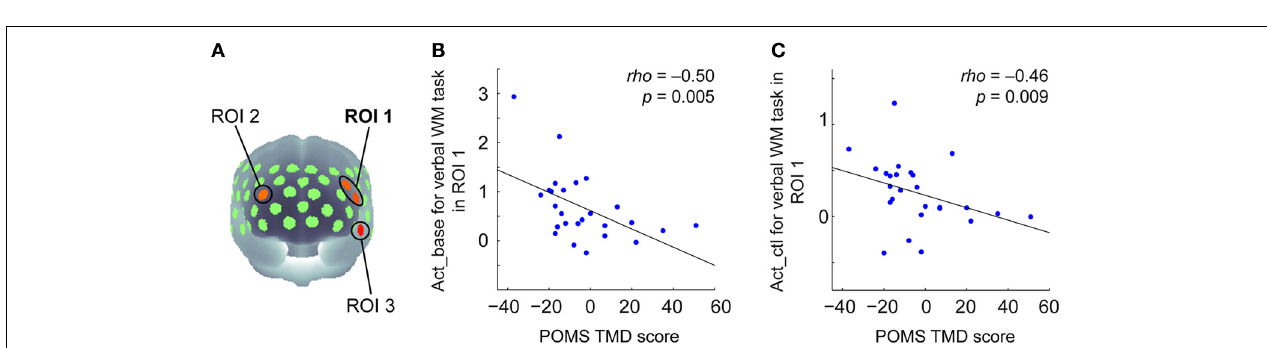
meet the p -value criteria described below each map. (C) Time courses of Hb-signal in a representative channel (Ch 25). These time courses represent the grand average across all participants ( N = 26) with standard error (transparent color region). The green vertical lines show the time of (a) Target onset and (b) Test onset, respectively.